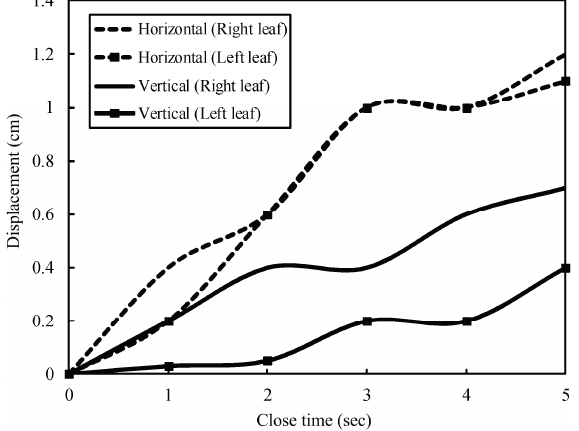
Figure 15. Single-pair leaf opening experiment curve (open time vs. displacement value).